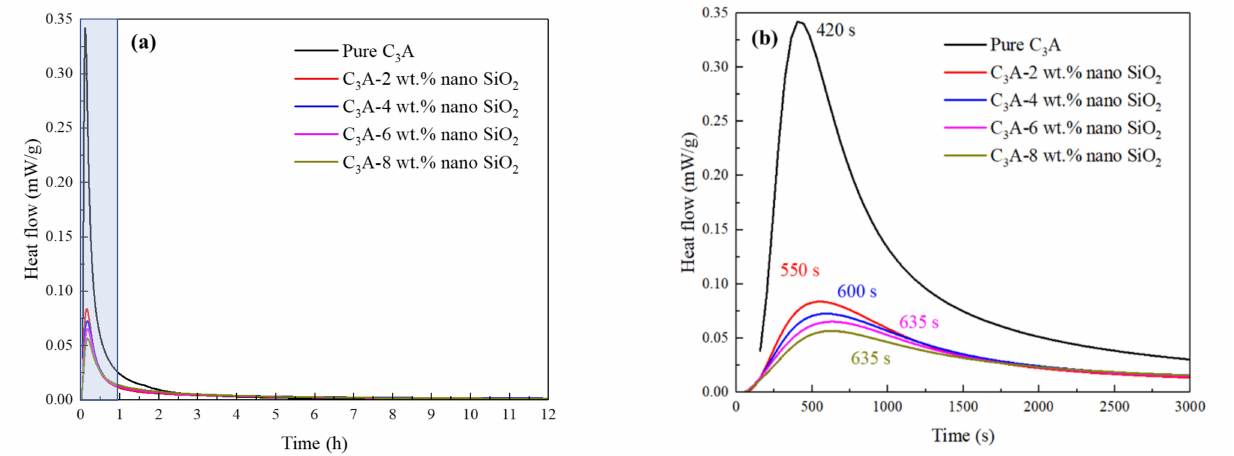
Figure 3. Heat flow rate of C 3 A samples with different nano-SiO 2 contents in ( a ) 12 h (the blue area is enlarged and displayed as ( b )) and ( b ) 3000 s (50 min). The number in ( b ) is the time needed to reach the maximum heat flow rate, in